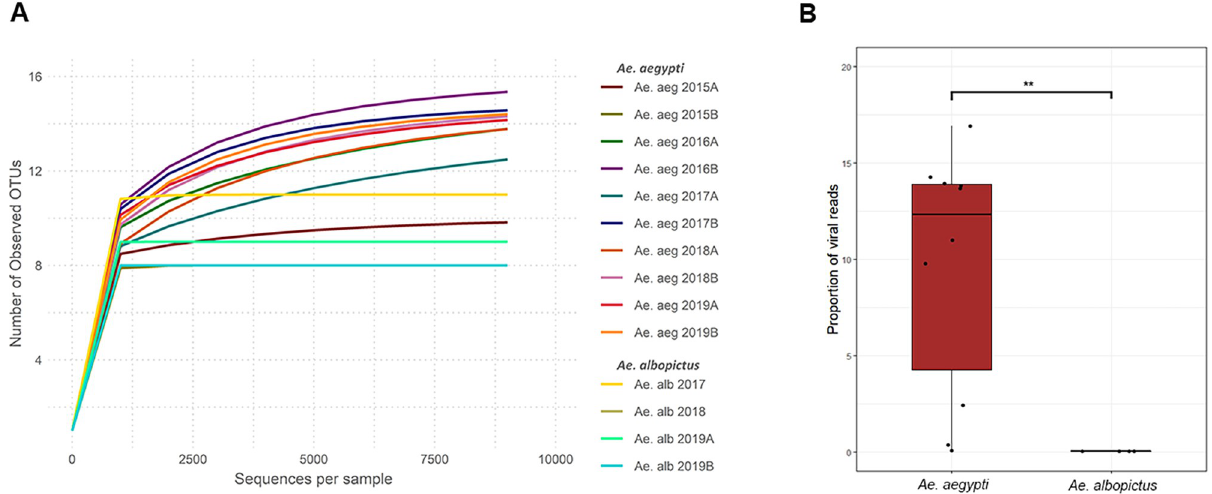
Fig 2. A. Rarefaction curves representing the viruses in Ae . aegypti and Ae . albopictus . B. Proportion of viral sequences relative to the number of mosquito host sequences. Mann–Whitney Test: p < 0.05 ( � ) and p < 0.01 ( �� ).